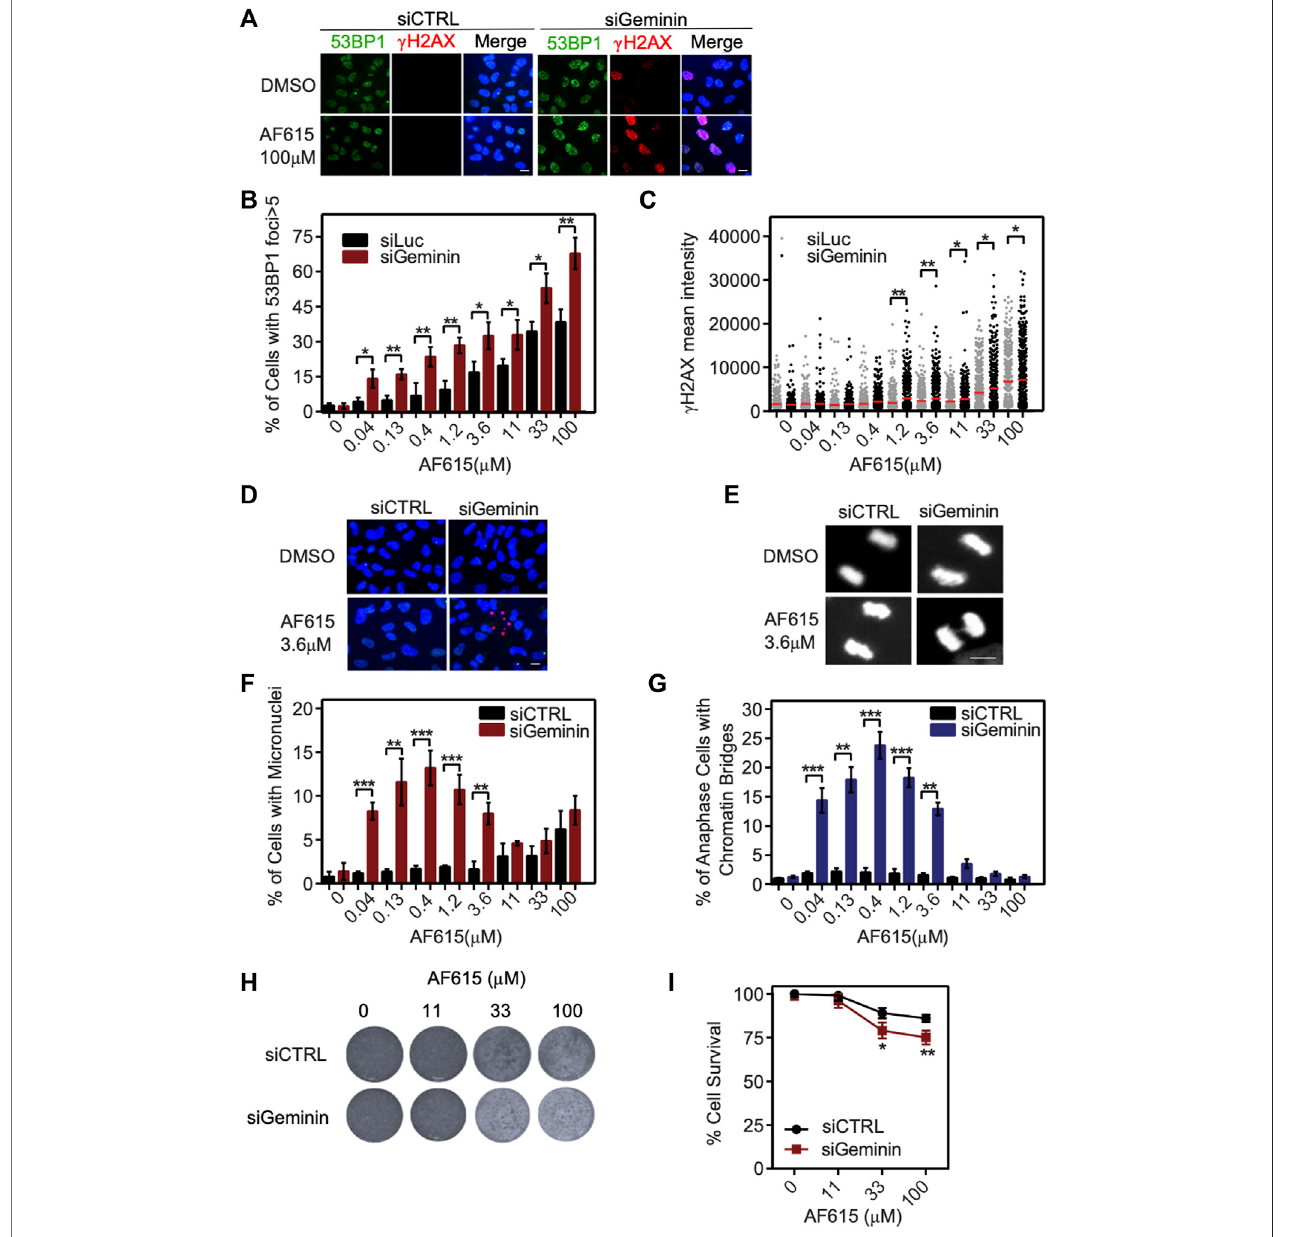
FIGURE 5 | Geminin depletion enhances the potency of chemical compound AF615. (A) Representative images of RPE1 cells transfected with Geminin siRNA, treatedwith33 μ McompoundAF615for24 handimmunostainedfor γ H2A Χ and53BP1.NucleiwerecounterstainedwithHoechst.RPE1cellstransfectedwithsiCTRL were used ascontrol. (B) Quanti fi cation ofthe % percentage of cells with 53BP1 foci. Statistical signi fi cance determined by two-tailed Student ’ s t -tests; ** p < 0.01; * p < 0.05; n = 3 biologically independent replications. (C) Scatter plot depicts the per cell γ H2A Χ mean intensity for the different compound AF615 concentrations examined. At least 1,000 cells were analyzed per condition and per experimental replicate. Statistical signi fi cance determined with Mann – Whitney U -tests; ** p < 0.01; * p < 0.05; n = 3 biologically independent replications. (D) Representative images of micronuclei detected in RPE1 cells transfected with Geminin siRNA and treated with compound AF615 for 24 h. (E) Representative images showing chromatin bridges in anaphase cells following depletion of Geminin and treatment with compound AF615. (F) Graphicalrepresentation ofthe%percentage ofcellsharboring micronuclei.Meansand SDs(error bars)from n =3biologicallyindependent experiments are shown, *** p < 0.001, ** p < 0.01. Statistical analysis determined with two-tailed Student ’ s t -tests. (G) Quanti fi cation of the % percentage of anaphase cells having chromatinbridges. Means and SDs (error bars) from n =3biologicallyindependent experiments areshown, *** p < 0.001,** p < 0.01. Statistical analysis determined with two-tailed Student ’ s t -tests. (H) Crystal violet staining of cell survival upon treatment with AF615 in RPE1 cells transfected with Geminin and CTRL siRNAs. (I) Survival curves of RPE1 cells treated with increased concentrations of compound AF615 (0, 11, 33, and 100 μ M). n = 3 biologically independent experiments per compound concentration. Scale bars: 7 μ